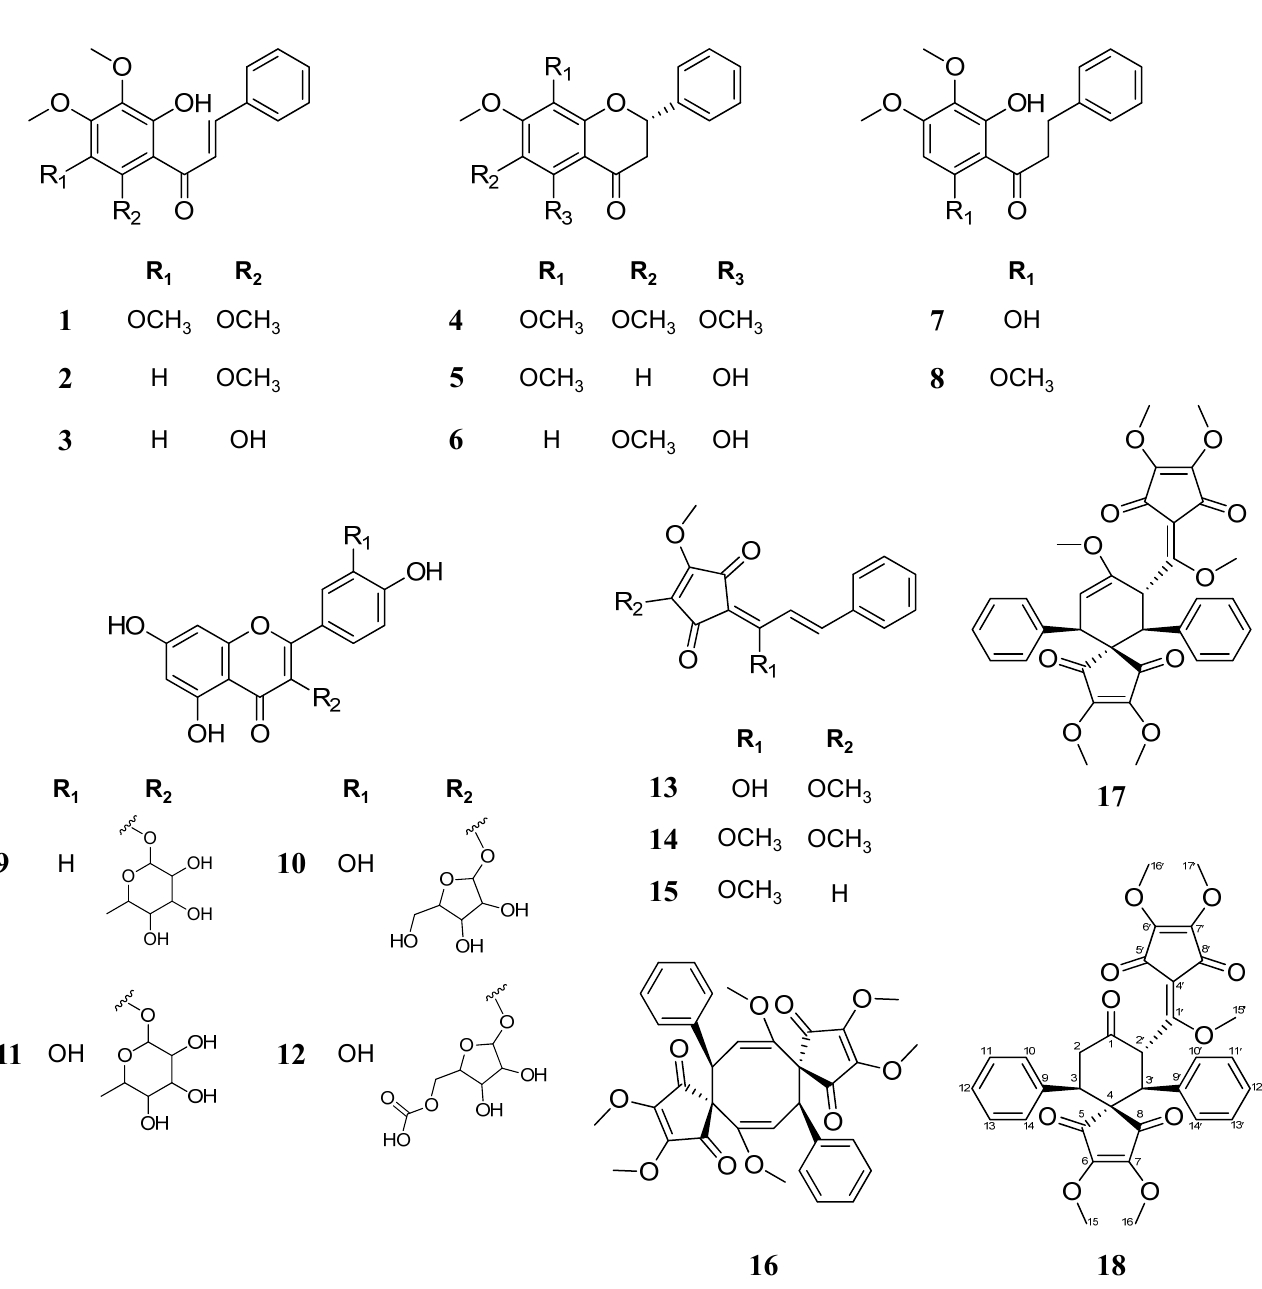
Figure 1. Structure of the compounds isolated from L. erythrocarpa leaves. Table 1. NMR spectroscopic data of demethoxy-bi-linderone ( 18 ).